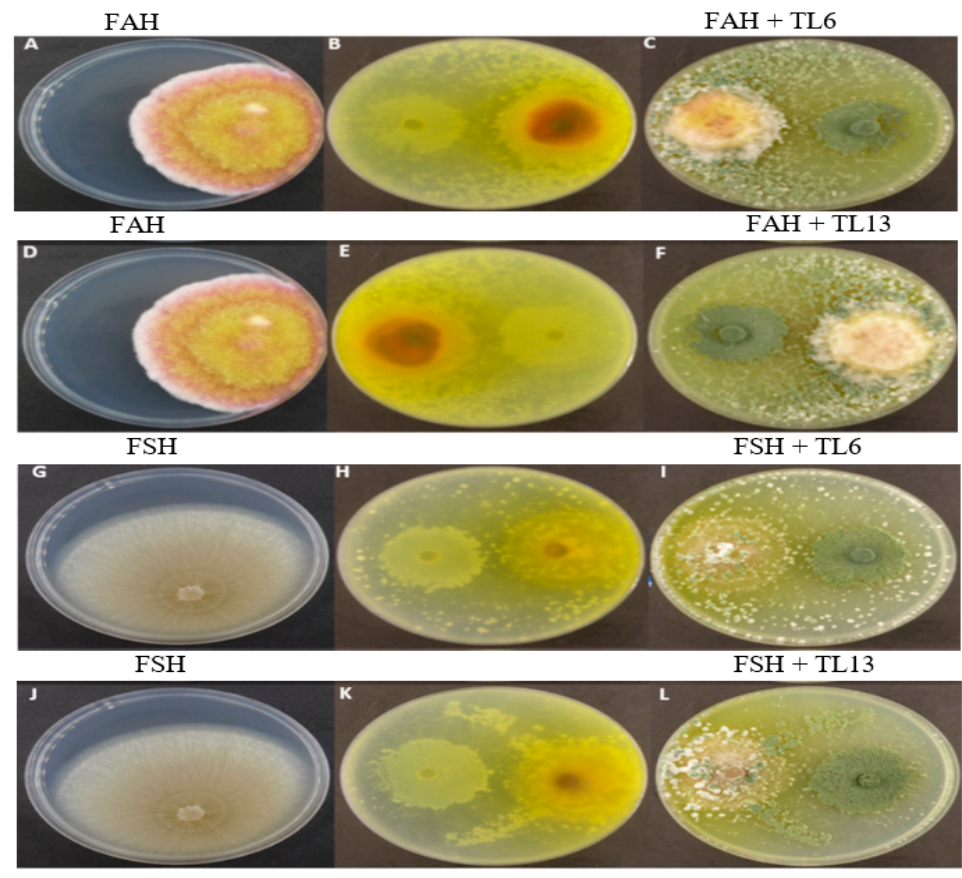
Figure 1. Effects of T. longibrachiatum (TL6 and TL13) on Fusarium avenaceum (FAH) and Fusarium solani (FSH) colony growth and inhibition after 7 days of dual-culture assay. ( A , D ) The front colony of F. avenaceum cultured for 7 days. ( B , C ) The reverse and front colony of FAH and TL6 confrontation culture. ( E , F ) The reverse and front colony of FAH and TL13 in confrontation culture. ( G , J ) A front colony of Fusarium solani (FSH) cultured for 7 days. ( H , I ) Reverse and front colony of FSH and TL6 confrontation culture. ( K , L ) FSH and TL13 confrontation culture of reverse and front colony. Microscopic Observations of the Mycoparasitic Effects of TL6 and TL13 on F. solani and